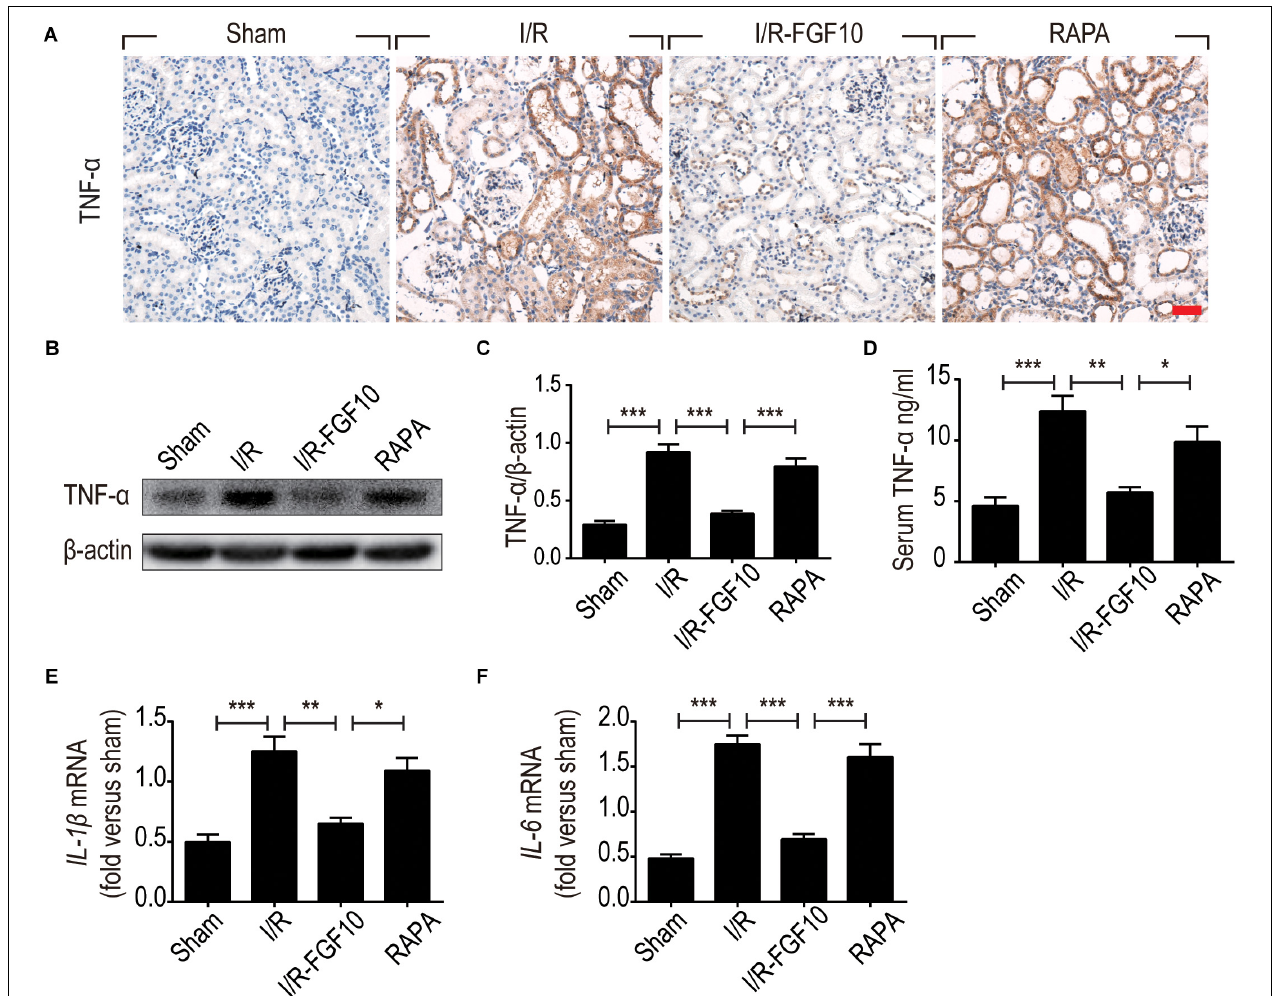
FIGURE 8 | FGF10 regulates the expression of inflammatory cytokines. (A) IHC staining for TNF- α in kidney tissues from indicated groups. Scale bars = 50 µ m. (B,C) The expression of TNF- α was detected by western blot using TNF- α specific antibody. Optical density analyses (mean ± SEM; n = 5) with β -actin as control. (D) Levels of serum TNF- α were determined by ELISA (mean ± SEM; n = 5). ∗ P < 0.05, ∗∗ P < 0.01, ∗∗∗ P < 0.001. (E,F) The mRNA expression of Il-1 β and Il-6 in the kidney was examined by RT-qPCR and normalized to Gapdh. ∗ P < 0.05, ∗∗ P < 0.01, ∗∗∗ P < 0.001.